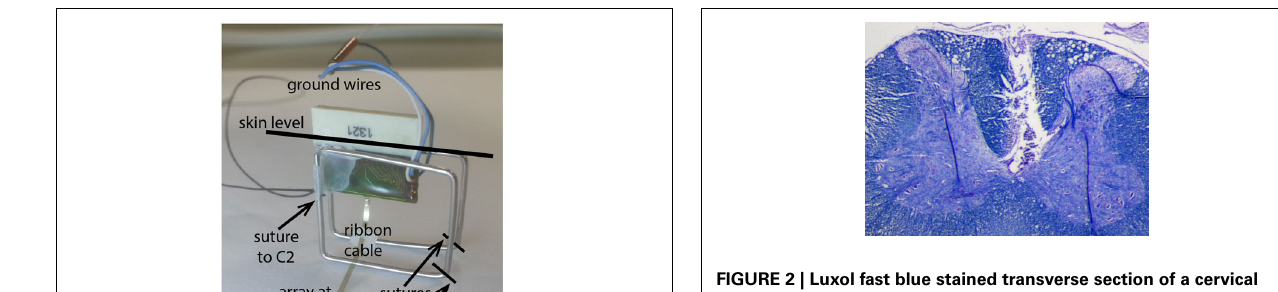
FIGURE 2 | Luxol fast blue stained transverse section of a cervical spinal cord from one of the rats. The lesion demarcates where the electrode array was implanted in the dorsal white matter. Because the tissue around was well attached to the substrate during three weeks of implantation time, it was ripped and stayed on the electrode during the explantation. Scale bar is 0.5mm. 17, ATI systems), integrated into the lever, measured the 3D forces applied to the contact pad at the tip of the lever by the rat’s arm ( Figure 3 ). Three dimensional force and position